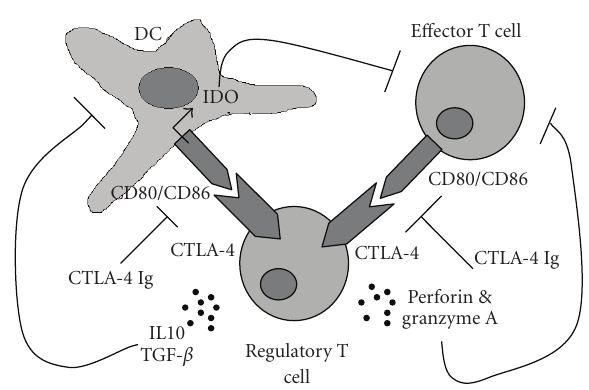
Figure 1: Possible mechanisms of suppression by regulatory T cells (Tregs). Tregs mediate their suppressive action by direct cell-cell contact mediated by CTLA-4 on both e ff ector T cells as well as antigen-presenting cells (APCs), such as dendritic cells (DCs). Pro- duction of immunosuppressive cytokines, such as IL-10 and TGF- β , suppresses DC maturation, making DCs tolerogenic. Moreover, Tregs can kill e ff ector T cells by expression of perforin and granzyme A. The figure also indicates therapeutic action of the anti-CTLA-4